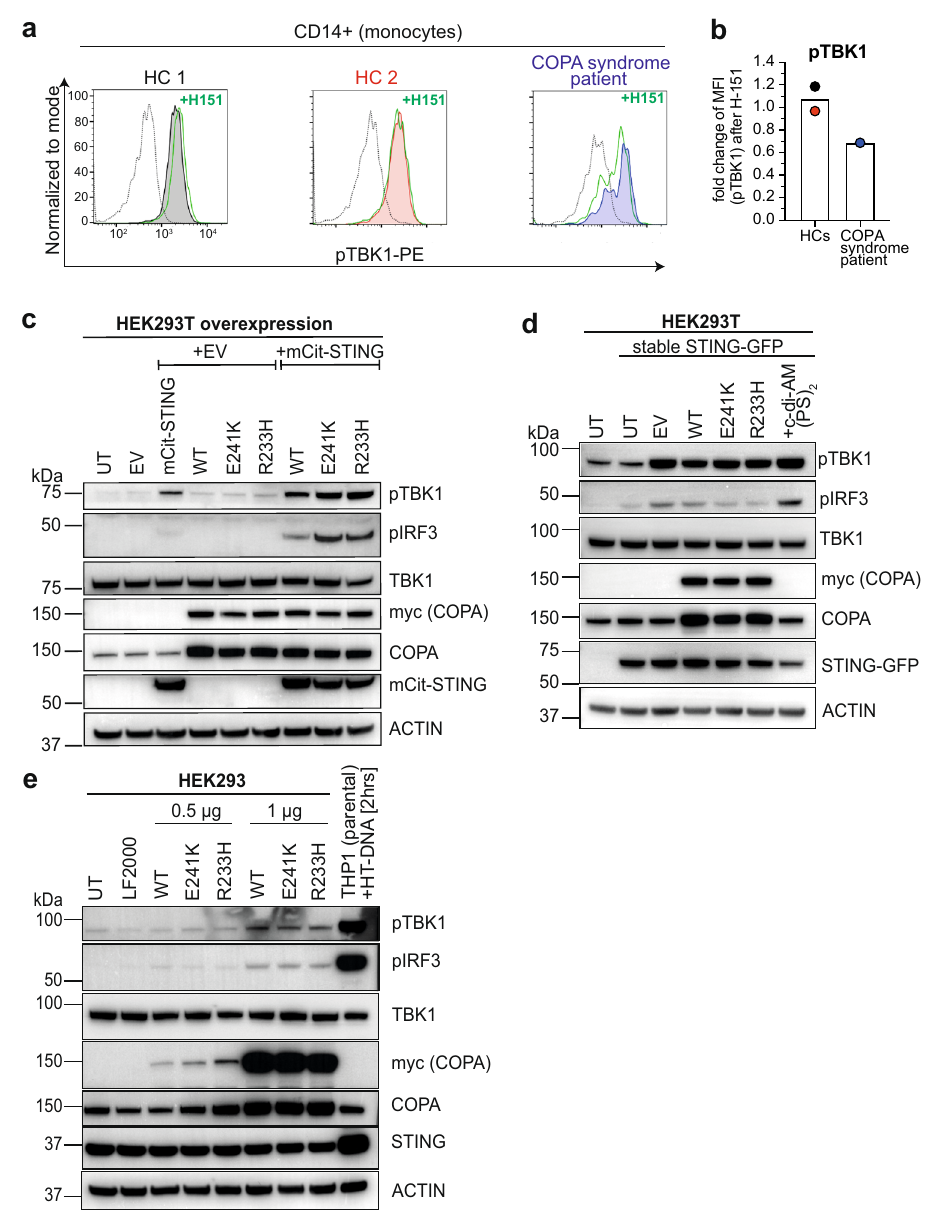
Fig. 3 Mutations in COPA trigger STING-dependent in fl ammation. a Representative histograms of fl ow cytometry analysis for phosphorylated TBK1 (pTBK1, used fl uorochrome PE) in monocytes (CD14 + /CD3-) isolated from PBMCs of one COPA syndrome patient (blue) 6 and two healthy control individuals (HCs) (black, red) before and after treatment with STING inhibitor H-151 (5 µ M) for 4 hrs (green line). Dotted line represents isotype control. n = 1. b Quanti fi cation of data shown in ( a ). Bar graph represents fold change in pTBK1 geometric mean fl uorescence intensity (MFI) following H-151 treatment relative to untreated control. Data presented as mean of two independent HCs from n = 1 experiments. c Western blot analysis of HEK293T cells following co-overexpression of mCit-STING and COPA mutants E241K and R233H (0.5 µ g DNA per construct) 24 hrs after transfection. Representative result of n = 3. d Immunoblot analysis of stably STING-GFP-expressing HEK293T cells 24 hrs after transient transfection with 0.5 µ g plasmid DNA encoding COPA WT or mutants. Untransfected cells stimulated with c-di-AM(PS) 2 (20 µ M, 2 hrs) are shown as control (last lane). Representative result of n = 3 experiments. e HEK293 cells (express endogenous STING) were transiently transfected with COPA WT or mutants (0.5 µ g or 1 µ g DNA/well) and harvested for western blot analysis after 24 hrs. As a positive control, cell lysate of THP-1 cells stimulated with HT-DNA (2 µ g/ml, 2 hrs) was